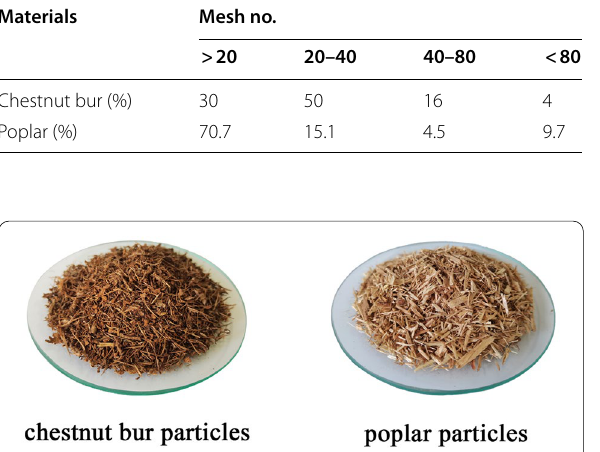
Fig. 1 Chestnut bur and poplar particles